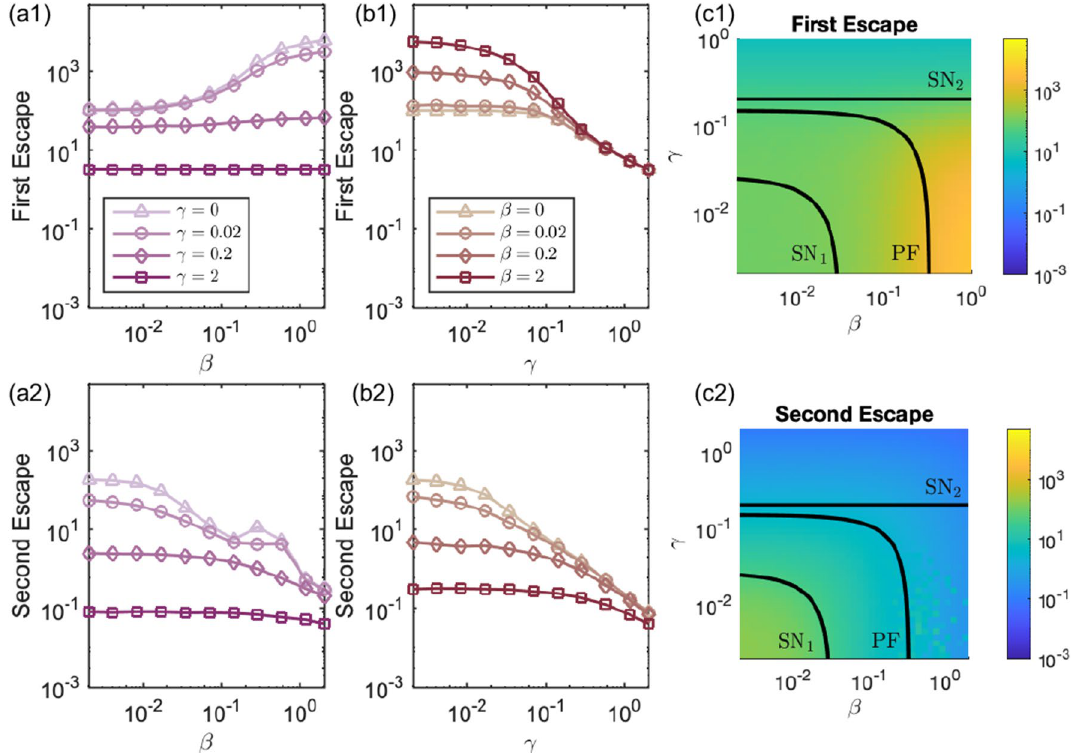
Figure 2. Mean times for the first node to escape (First Escape, row 1) and second node to escape (Second Escape, row 2). Column ( a ) shows mean escape times against β for different fixed values of γ ; Column ( b ) shows mean escape times against γ for different fixed values of β . A legend indicates the fixed values in each column. Column ( c ) plots the mean escape times on the ( γ , β )-plane with the bifurcation curves